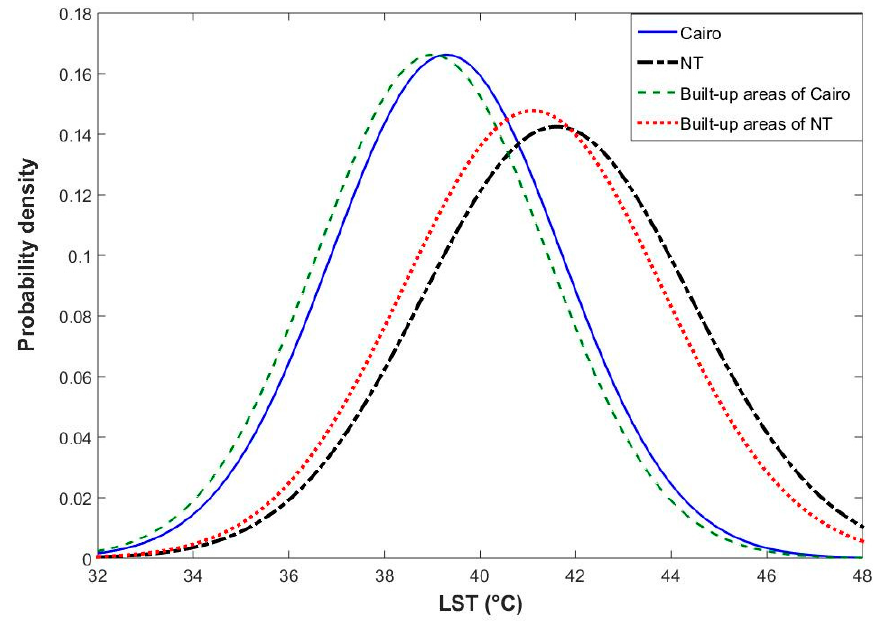
Figure 5. The probability density functions of daytime mean LST during the summer: Cairo (solid blue line), NT (dash-dot black line), built-up areas of Cairo (dash green line) and built up areas of NT (dot redline).